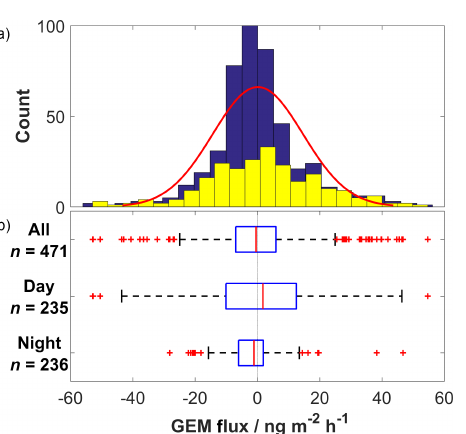
Figure 2. (a) Histogram of GEM flux values. Yellow bars represent diurnal data; blue bars represent nocturnal data. Red line is Gaussian fit to all data. (b) Box plots for all, diurnal and nocturnal GEM flux data. Red lines represent medians, blue boxes inter-quartile range (IQR), whiskers 1.5 · IQR and red crosses